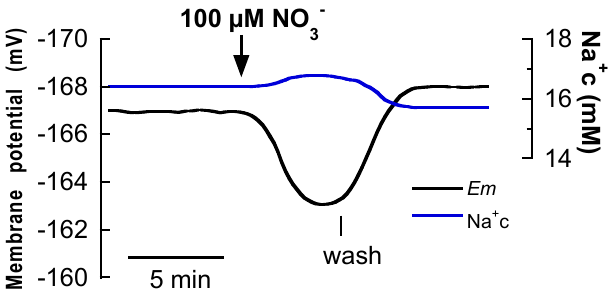
Figure 2. Effect of the addition of 100 µ M NO 3 − on membrane potential and cytosolic Na + concentration of P. oceanica mesophyll leaf cells. Black trace shows the membrane potential ( Em , mV) and the blue one corresponds to the cytosolic Na + concentration (Na + c, mM) simultaneously measured. The downward arrow indicates the addition of NO 3 − and the vertical line the onset of the wash. Traces are a representative example of three equivalent measurements.